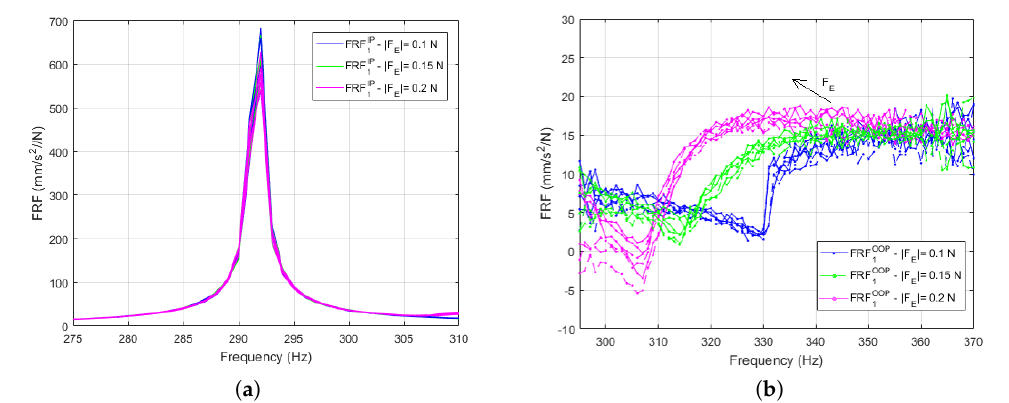
Figure 7. ( a ) IP and ( b ) OOP FRFs for different excitation levels, tests repeated after having switched off and on the compressed air system.